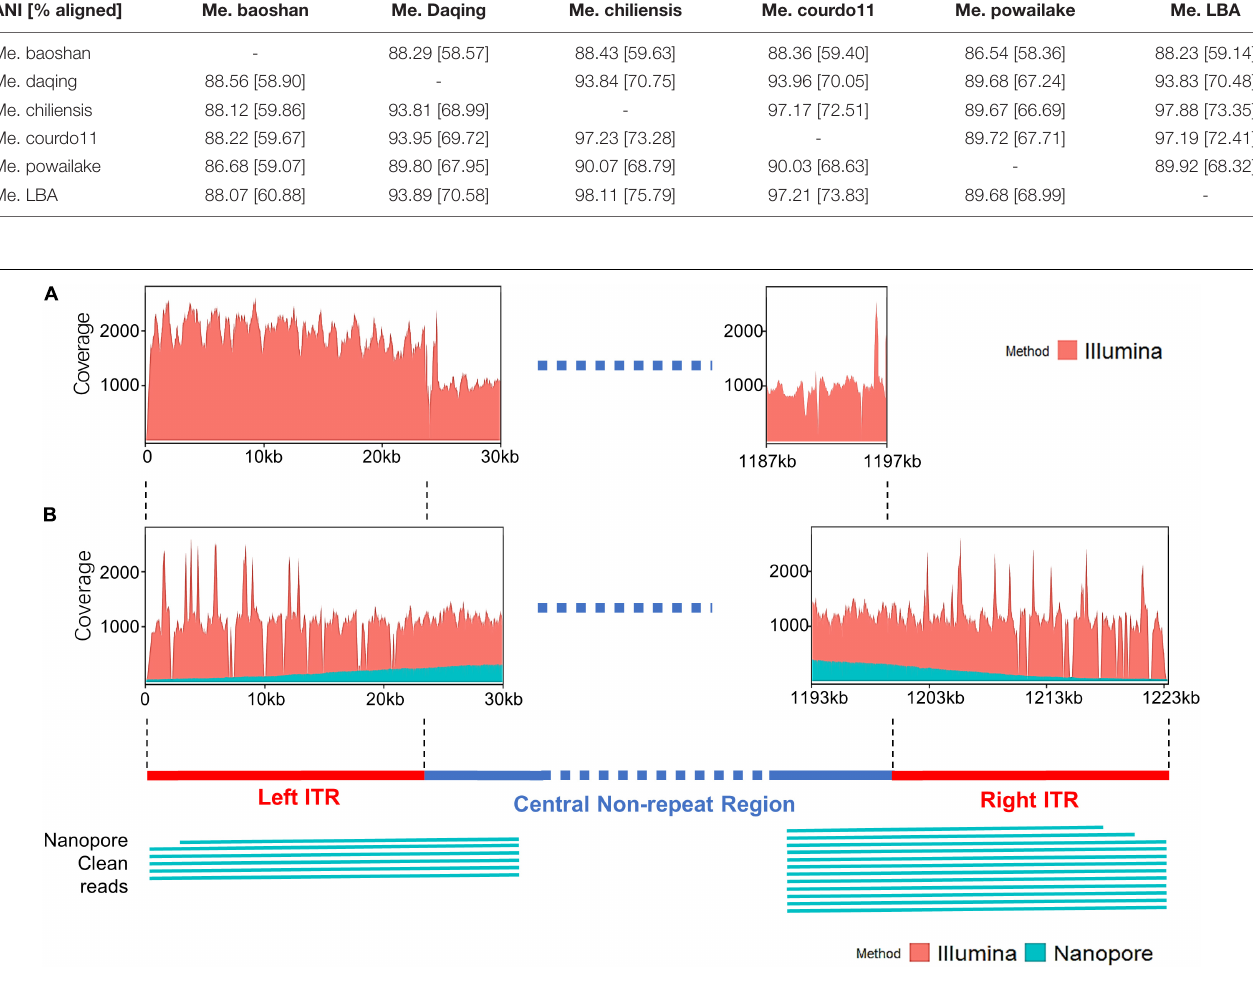
of Mimivirus lineage